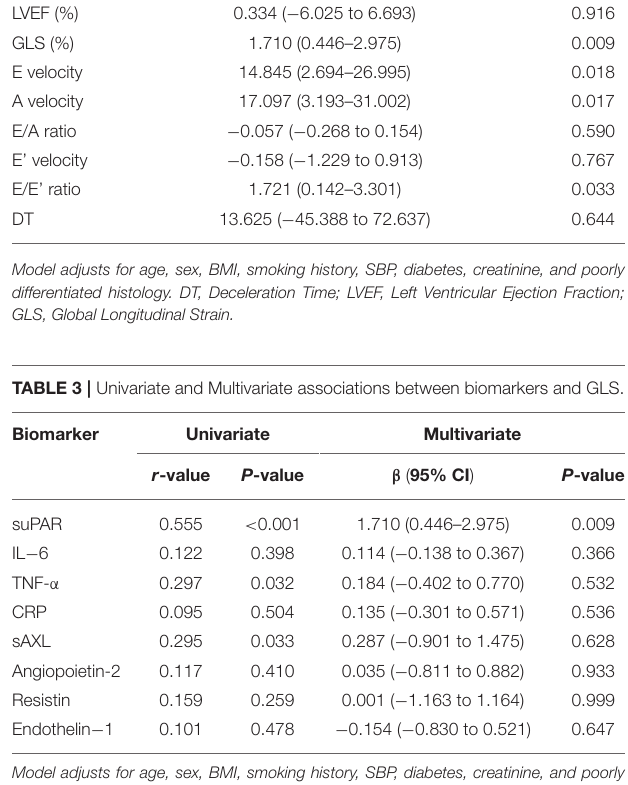
Model adjusts for age, sex, BMI, smoking history, SBP, diabetes, creatinine, and poorly differentiated histology. CRP, C-reactive protein; IL-6, interleukin-6; LVEF, Left